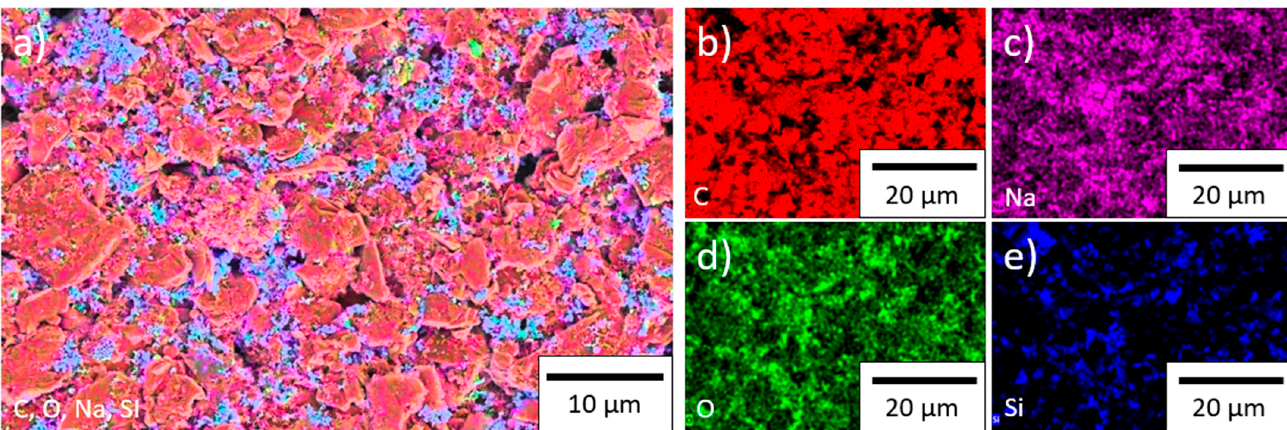
Nanomaterials 2021 , 11 , x FOR PEER REVIEW 23 of 27 Figure A4. EDX measurements of the graphite electrode: ( a ) all detected elements, ( b ) carbon, ( c ) sodium, and ( d ) oxygen.